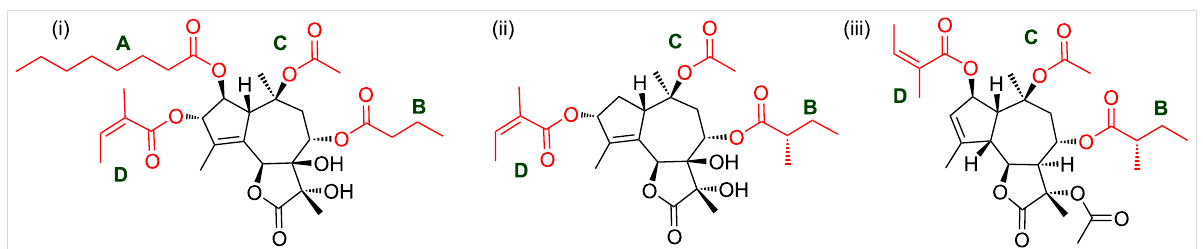
Figure 6: Structural formulae of (i) thapsigargin, (ii) trilobolide ( 2 ), and (iii) archangelolide ( 1 ). Red parts show structural moieties of thapsigargin and its derivatives contributing to SERCA binding affinity (according to [22]): A) octanoyl, B) butanoyl or 2-methylbutanoyl, C) acetyl, D) angeloyl.